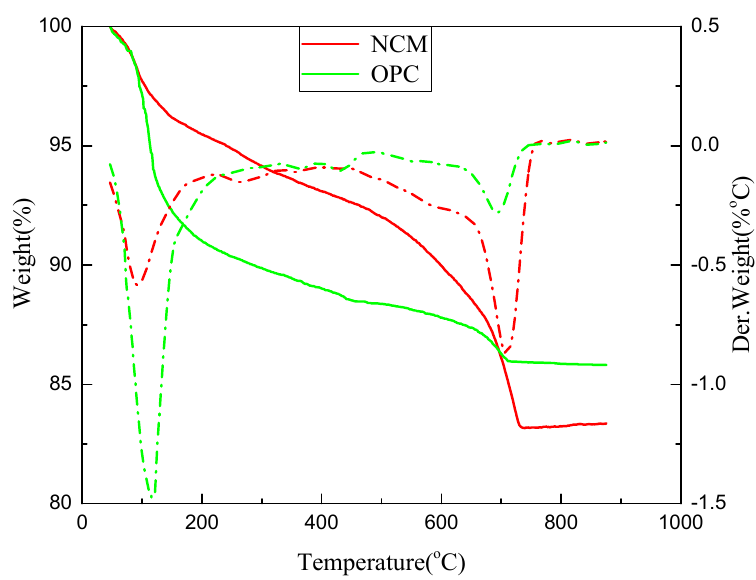
Figure 8. TG/ differential thermal gravimetric (DTG) images of NCM and OPC for 7 days of curing time.